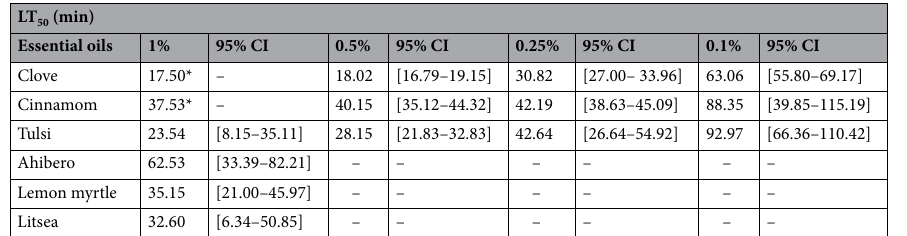
Table 3. LT 50 values measured by minute for all stages of sarcoptes (*most of sarcoptes died before 30 min).